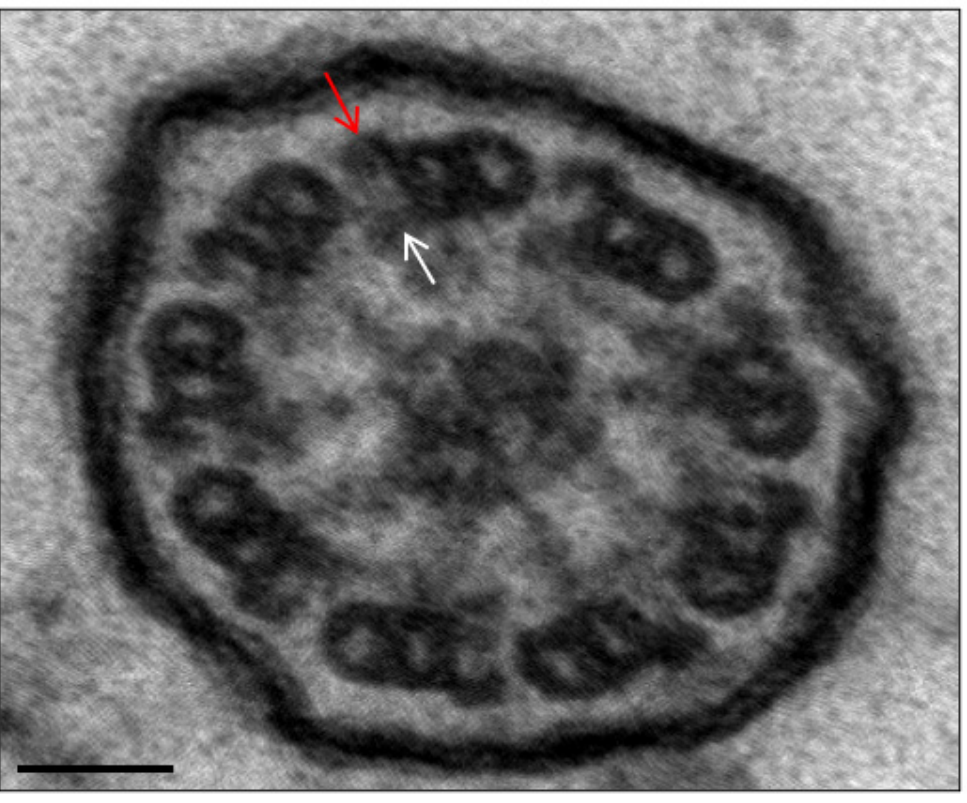
Figure 2. Ultrastructural image of a normal axoneme. Presence of the outer and inner dynein arms. Arrows point to outer (red) and inner (white) dynein arms as references. Bar: 50 nm.